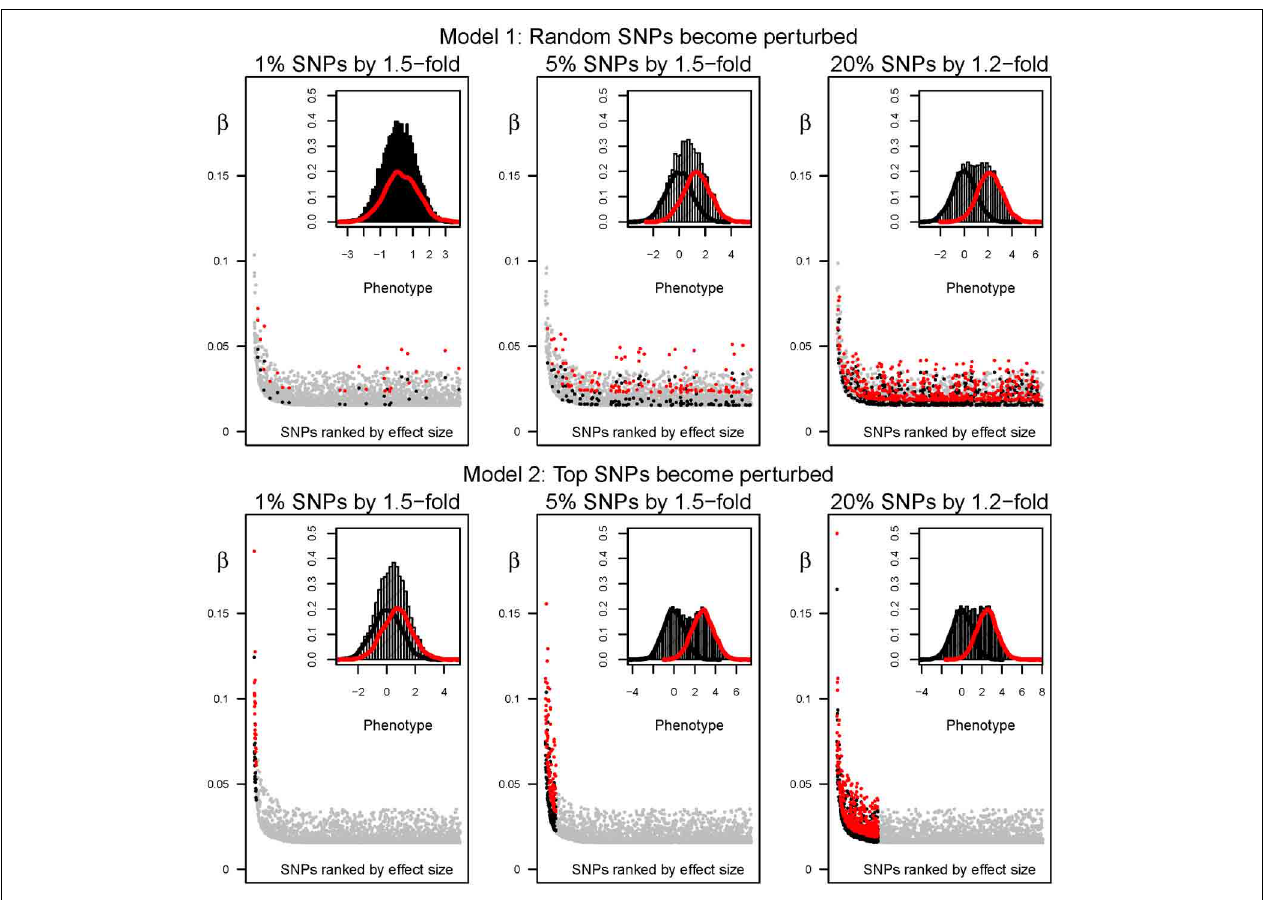
FIGURE 2 | Distribution of effect sizes and phenotypes before and after perturbation. From left to right, outcomes after perturbing the effect size of 1, 5, and 20% of the SNPs by 1.5, 1.5, and 1.2-fold, respectively. Top and bottom panels have been simulated under models 1 and 2, respectively. Major plot: the effect size ( β ) of the 2500 causal SNPs is shown in y-axis. SNPs are ranked in x-axis according to the percentage of variance explained by each variant in the “ancestral” environment (from left to right). Gray dots correspond to the effect size in the “ancestral” environment. The scaling